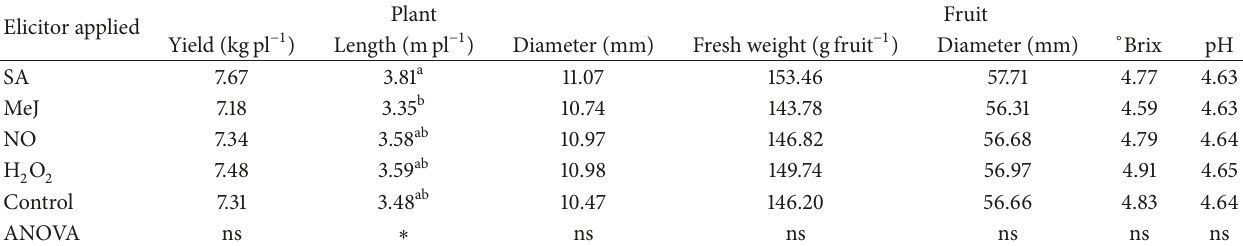
Table 1: Average physiological variables measured in the fruit and tomato plant throughout the experiment. Plant Fruit Elicitor applied